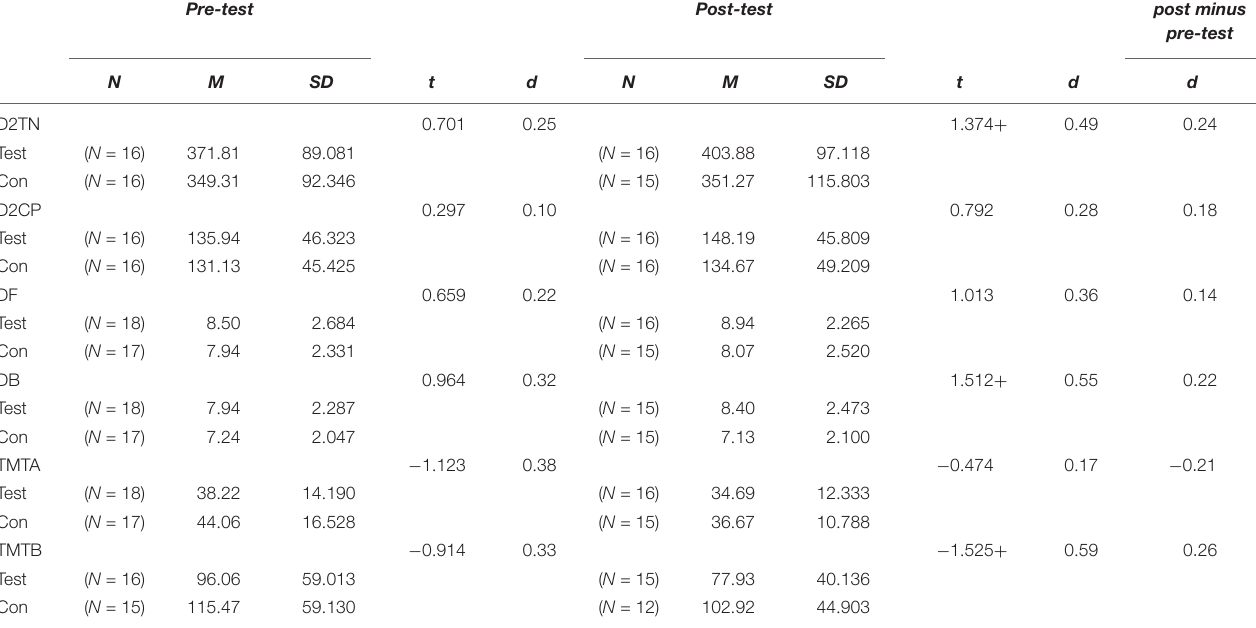
TABLE 2 | Differences pre and post-test. Pre-test